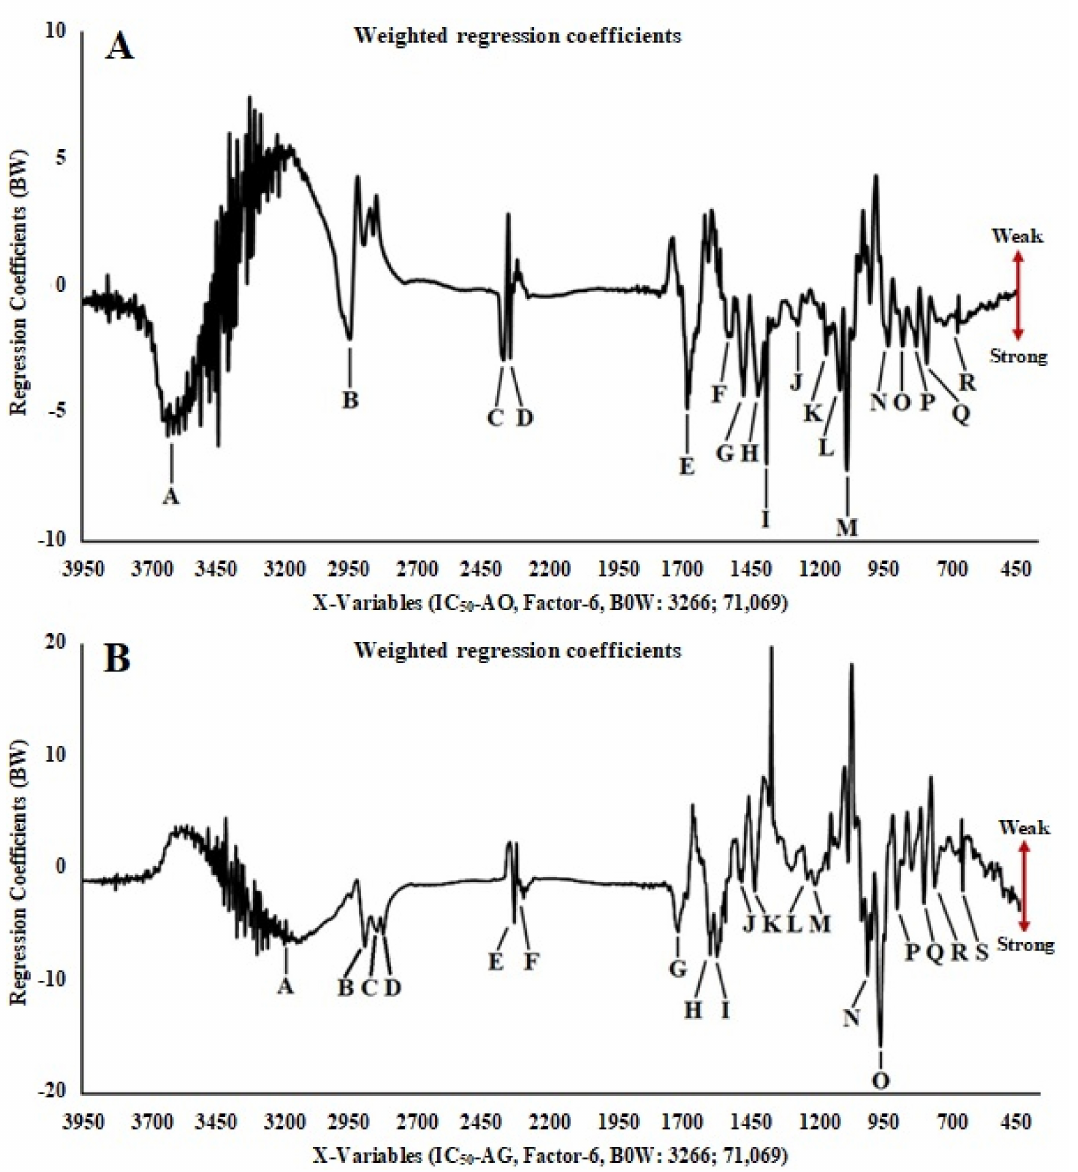
Figure 2. Partial least squares (PLS) plot weighted regression coefficients (important variables) of antioxidant ( A ) and α -glucosidase inhibitory ( B ) activities in 70% ethanol extract of C. orchioides and C. latifolia using FTIR